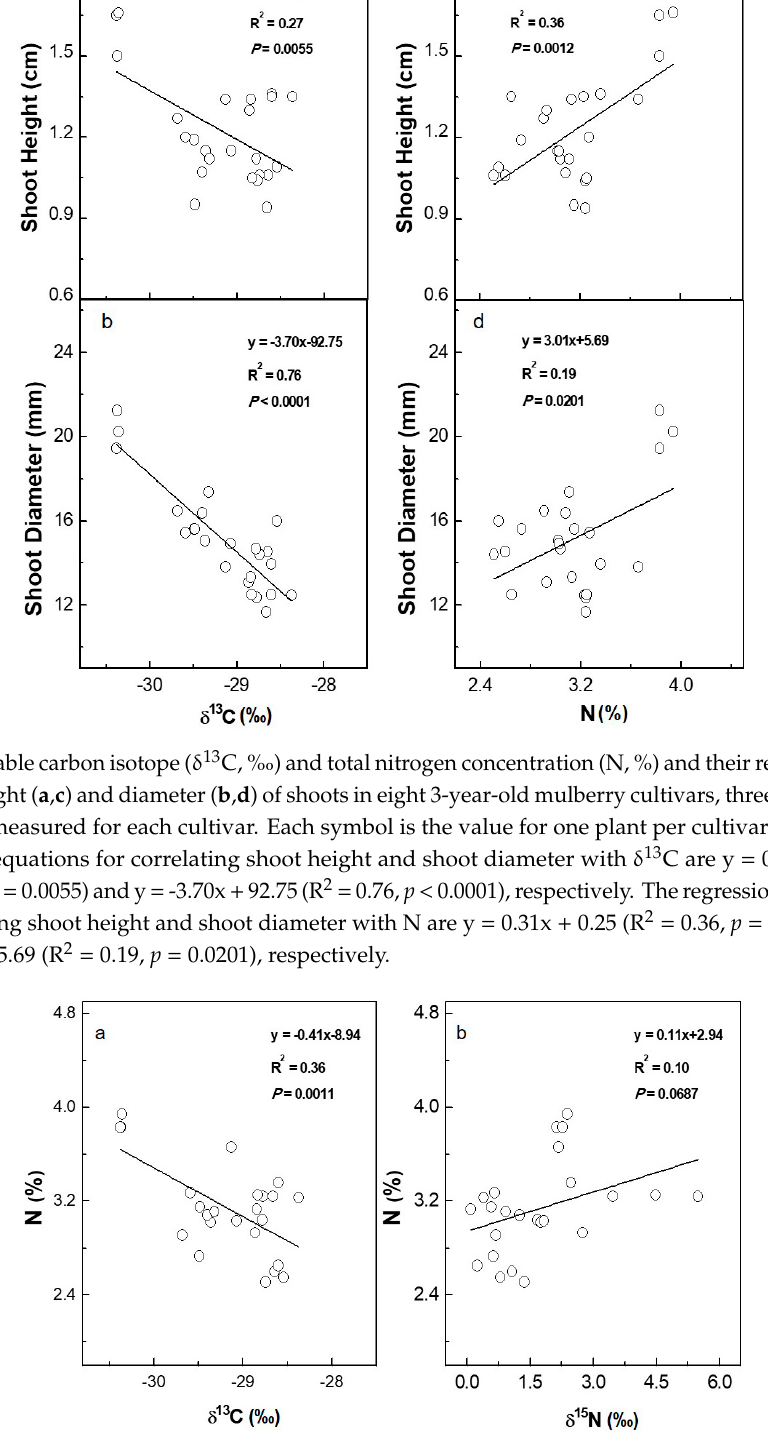
Figure 4. Relationships between leaf total nitrogen concentration (N, %) and stable isotopes of either carbon ( δ 13 C, % (cid:24) ) ( a ) or nitrogen ( δ 15 N, % (cid:24) ) ( b ) in eight 3-year-old mulberry cultivars, three individual trees were measured for each cultivar. Each symbol is the value for one plant per cultivar. The linear regression equations for correlating δ 13 C and δ 15 N with N are y = 0.41x – 8.94 (R 2 = 0.36, P = 0.0011) and y = 0.11x + 2.94 (R 2 = 0.10, P = 0.0687), respectively.